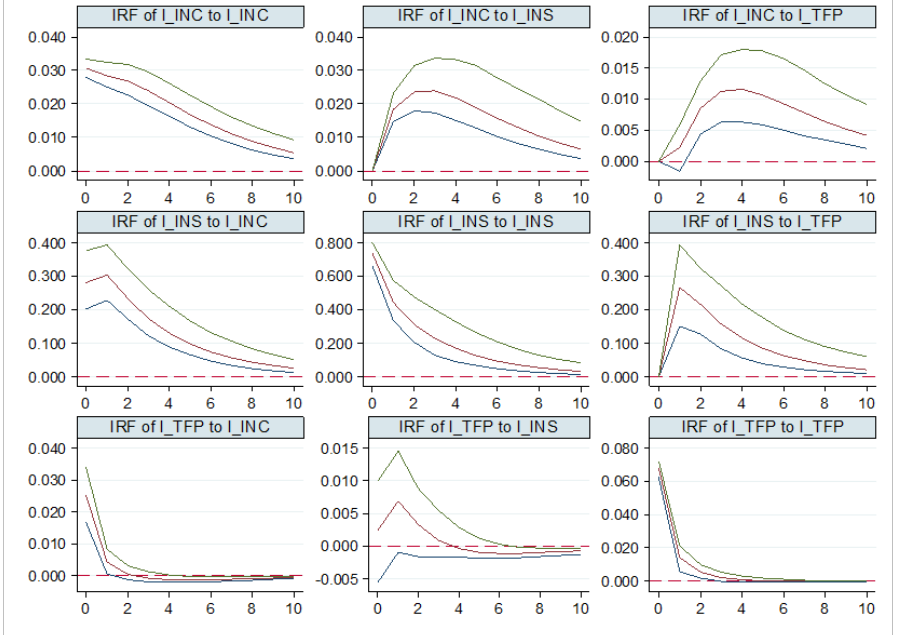
Figure 2. Impulse response diagram in low density areas.